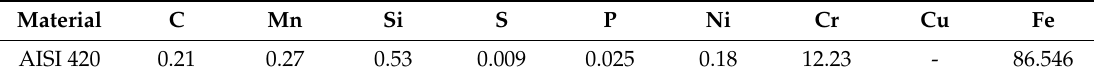
Table 1. The chemical composition of AISI 420 stainless steel (wt